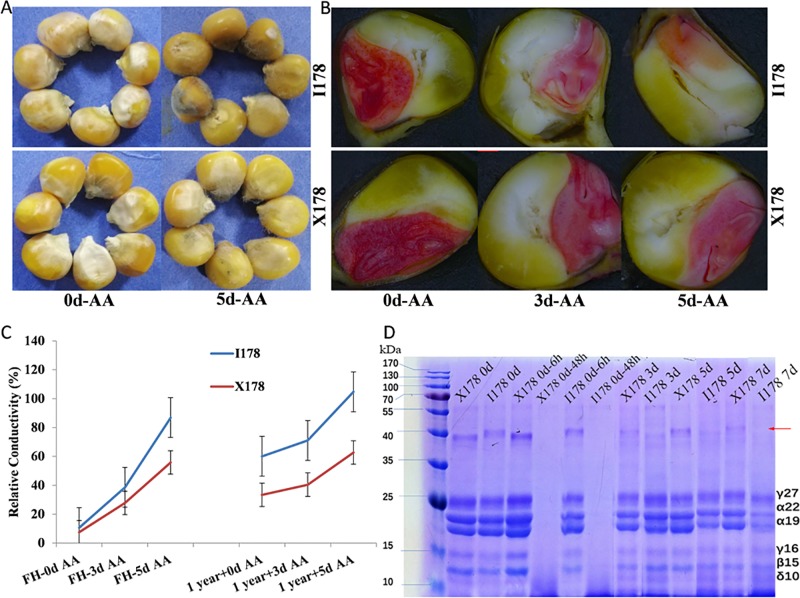
Storage characterization of I178 and X178 seed.A). Observation of 3d-AA and 5d-AA seeds; B). TTC staining of embryos at 0d-AA after 3d-AA and 5d-AA; C). The RC of FH seeds, one-year storage seeds treated with 3d-AA and 5d-AA; the dashed lines indicate the vigor of FH seeds after 5d-AA was lost more than that of one-year storage seeds. D). SDS-PAGE analysis of seeds zein, lanes 1–12: Dry seeds of X178 and I178 (X178-Dry, I178-Dry), X178 seeds after 6 h imbibed water (X178-0d-6h), 48 h germinated X178 seeds (X178-0d-48h), I178 seeds after 6 h imbibed water (I178-0d-6h), 48 h germinated I178 seeds (I178-0d-48h), X178 seeds after 3d-AA (X178-3d), I178 seeds after 3d-AA (I178-3d), X178 seeds after 5d-AA (X178-5d), I178 seeds after 5d-AA (I178-5d), X178 seeds after 77d-AA (I178-7d). The degradation of 40 kD protein is denoted by an arrow.